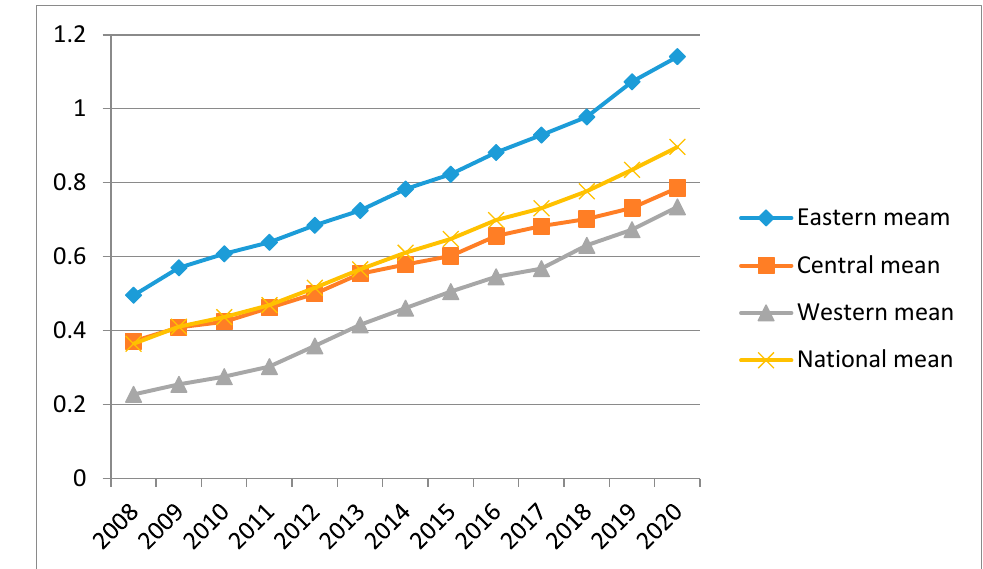
Figure 1. Variation of CEE of transportation in eastern, central, and western China.